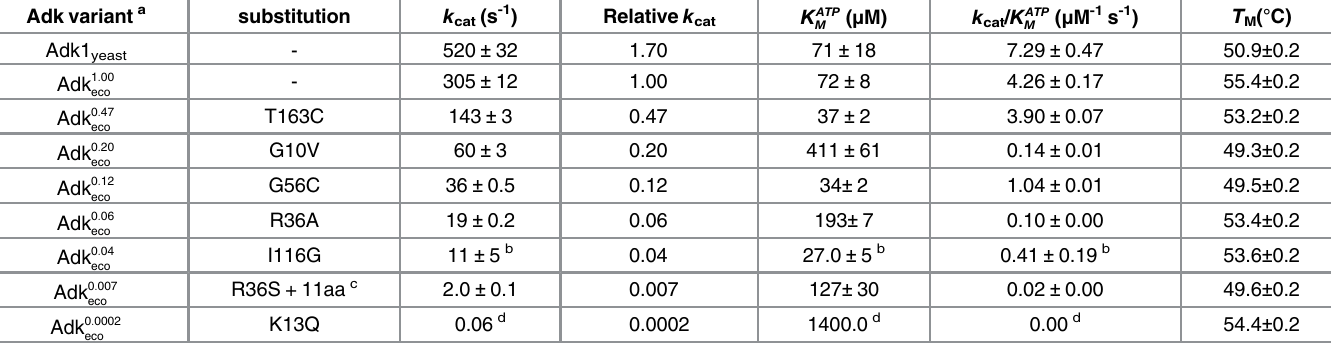
Table 1. Nomenclature, catalytic parameters and melting temperatures of Adk